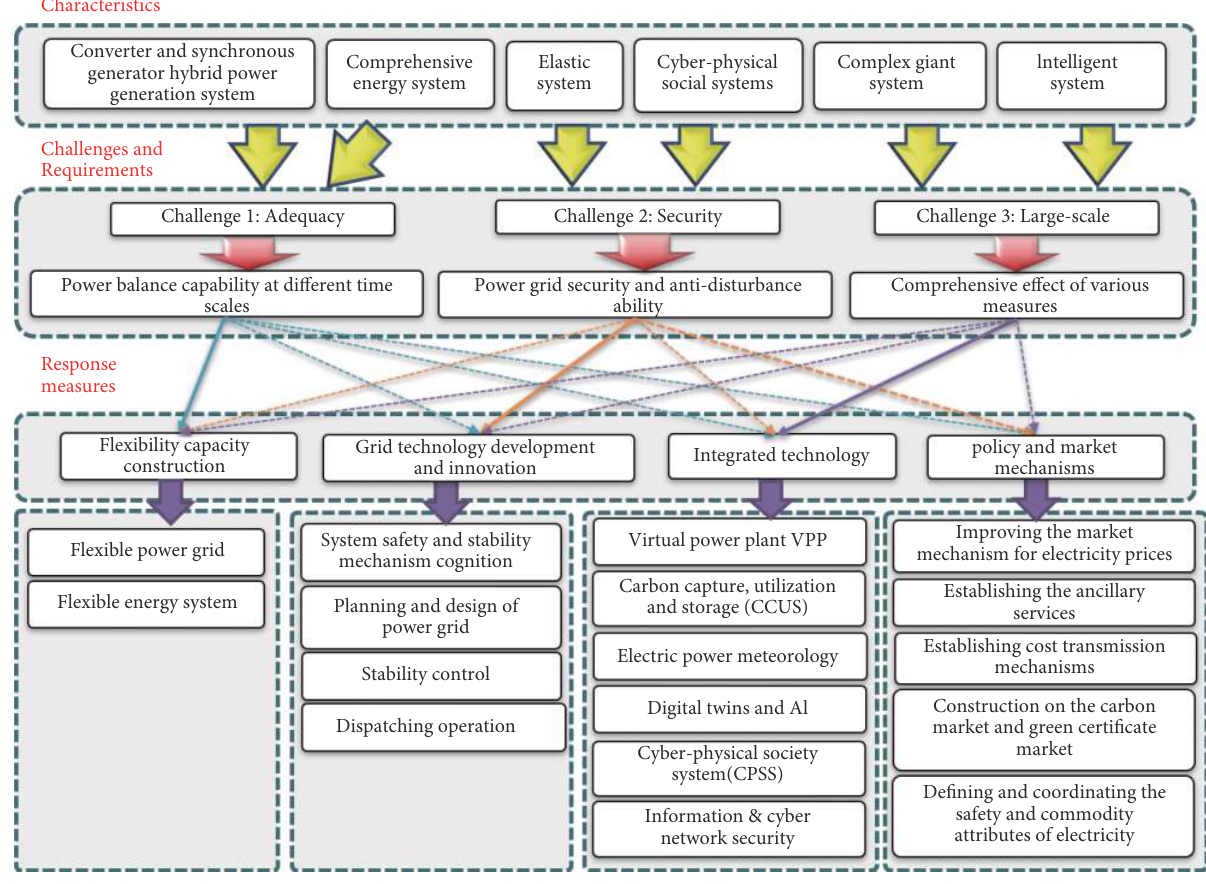
Fig. 7 Block diagram of key technology